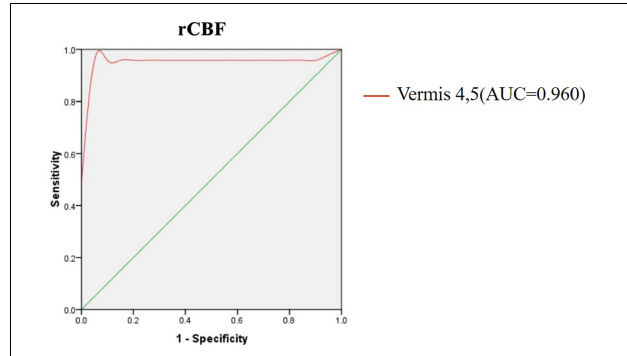
FIGURE 3 | ROC curve for CBF in vermis of patients with MSA and healthy controls. An optimal CBF cutoff value was determined at a sensitivity of 95.8% and specificity of 100%. The area under the curve (AUC) for the ROC was 0.960 (95% confidence intervals from 0.884 to